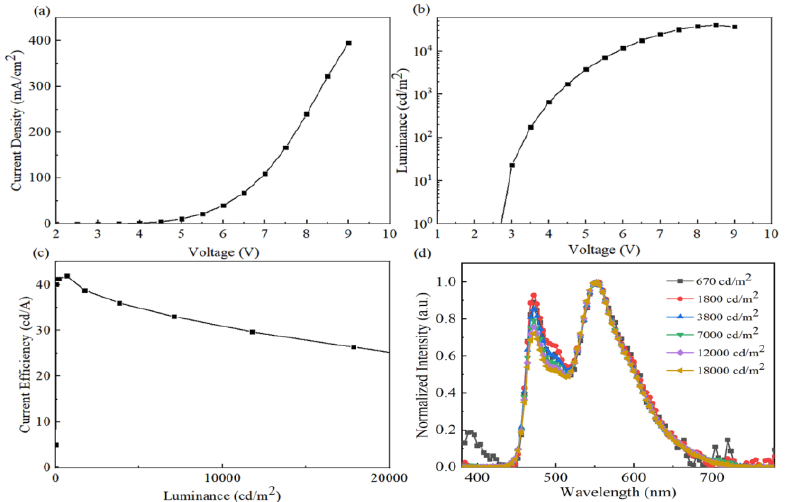
Figure 4. Current density – voltage ( a ), luminance – voltage ( b ), current efficiency – luminance ( c ) and normalized EL spectra at different luminance ( d ) characteristics of the white devices.